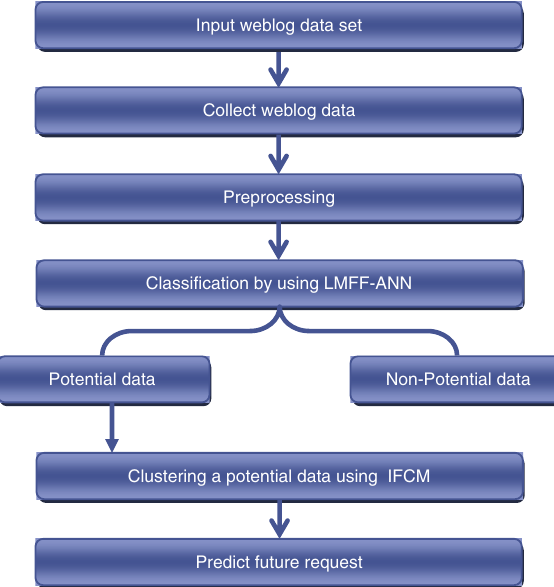
Figure 1: Proposed Future Request-Based Web Recommendation.